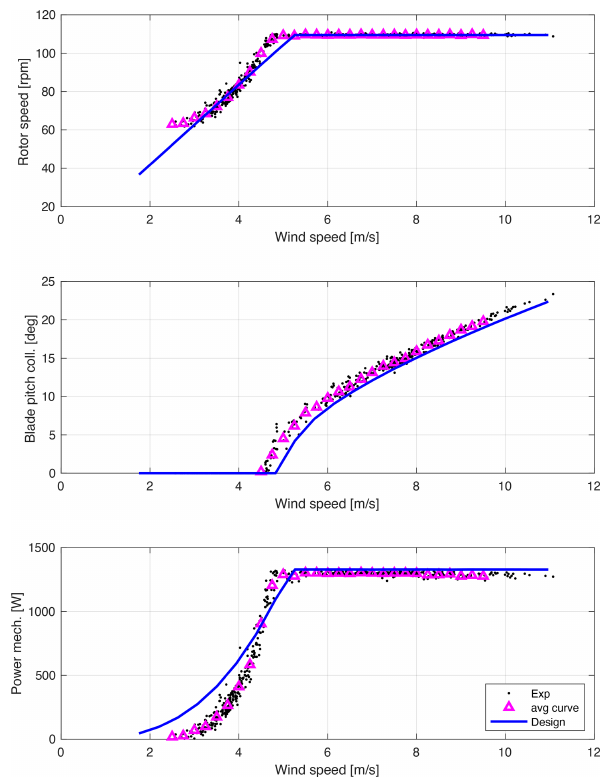
Figure 14. Steady-state controller performance